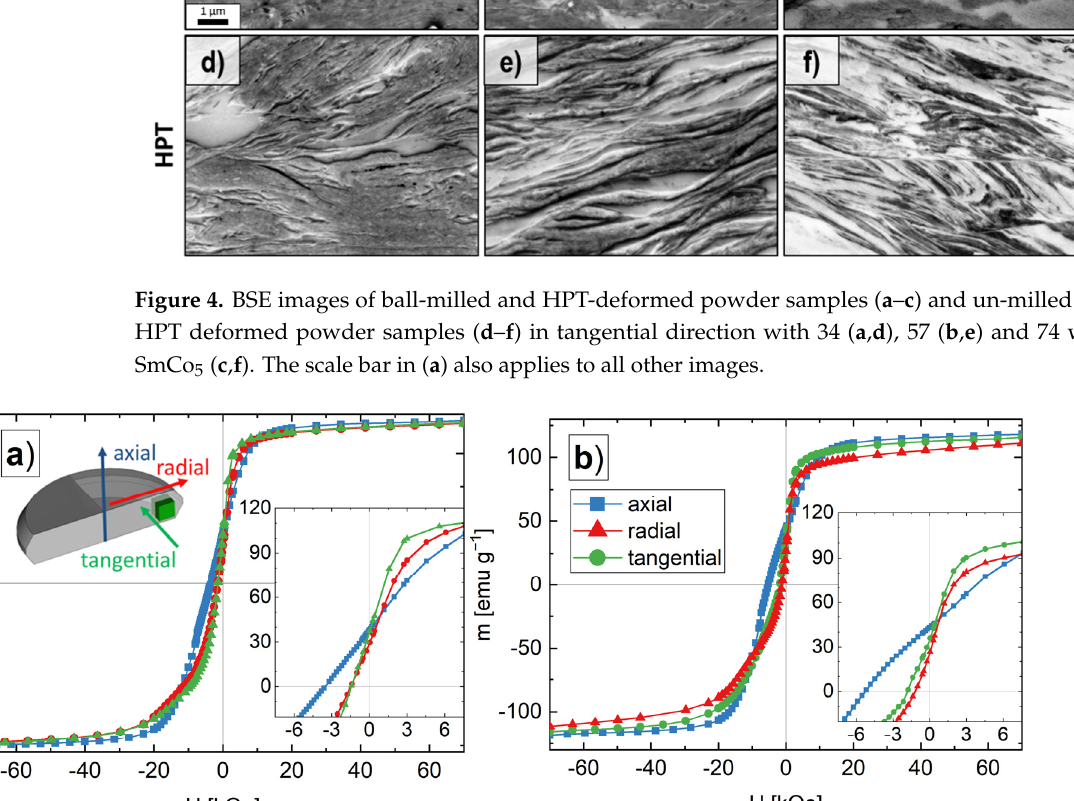
Figure 4. BSE images of ball-milled and HPT-deformed powder samples ( a – c ) and un-milled and HPT deformed powder samples ( d – f ) in tangential direction with 34 ( a , d ), 57 ( b , e ) and 74 wt.% SmCo 5 ( c , f ). The scale bar in ( a ) also applies to all other images.